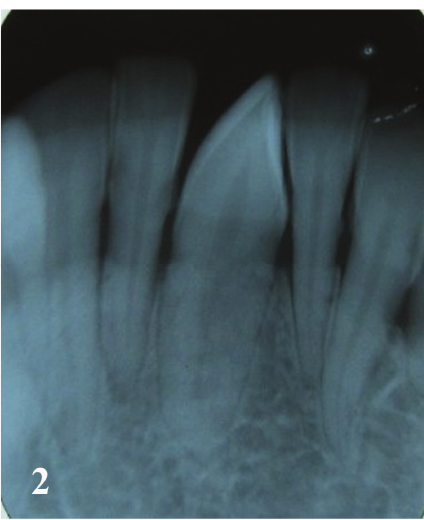
Figure 2: Periapical radiograph showing transmigrated and erupted lower left canine in the